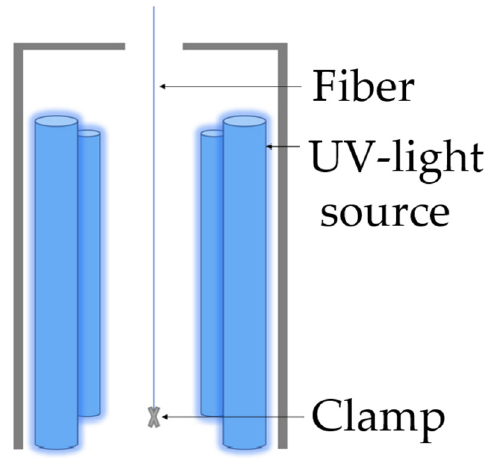
Figure 1. Schematic treatment of RCF with UV light.